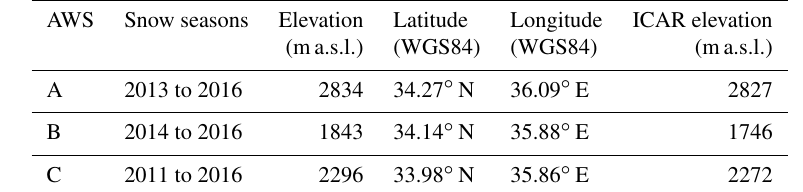
Table 1. AWS geographical coordinates and elevations. Elevation of the ICAR cell that contains each AWS.